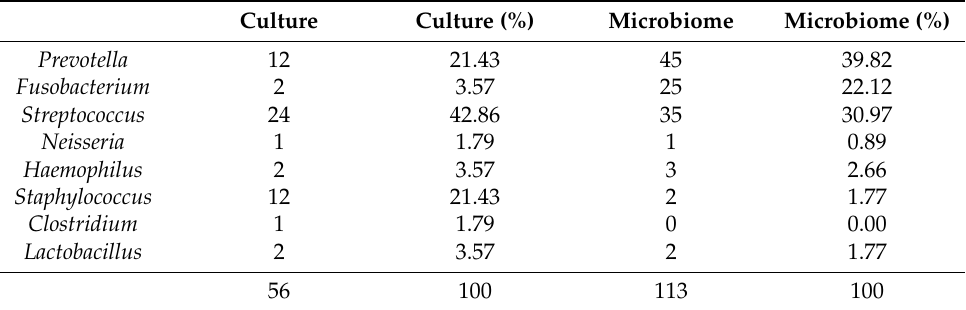
Table 1. 56 specifications of the culture analysis corresponded to a unique bacterial identification. These were compared with the corresponding identifications of the microbiome, requiring a relative abundance of at least 1%. Fisher’s exact test shows a significant difference between culture and microbiome ( p < 0.001).